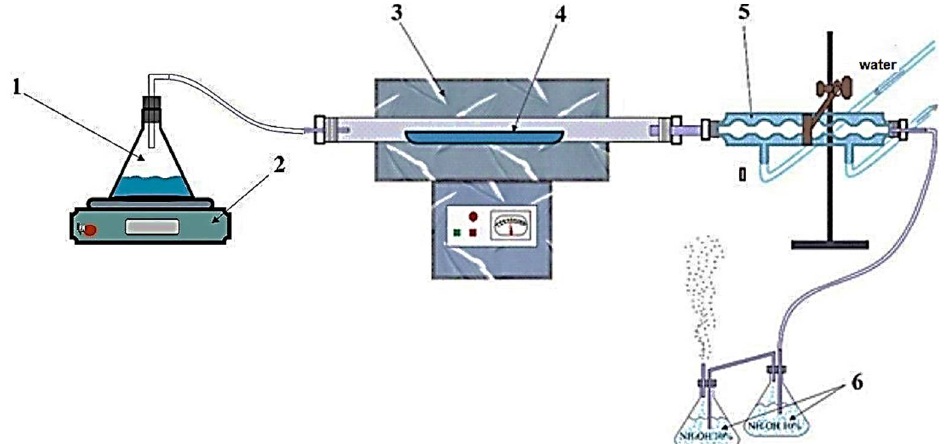
Figure 1. Laboratory setup for pyrohydrolysis. 1: flask with water; 2: electric stove; 3: oven LOIP LF/500–1200; 4: alundum boat; 5: refrigerator; 6: flasks with 10 wt% ammonia solution. Titanium dioxide was purified with a hydrochloric acid solution in a thermostated reactor with a volume of 0.5 dm 3 . The pulp was stirred with a glass stirrer. Stirrer rotation speed was 450 rpm.